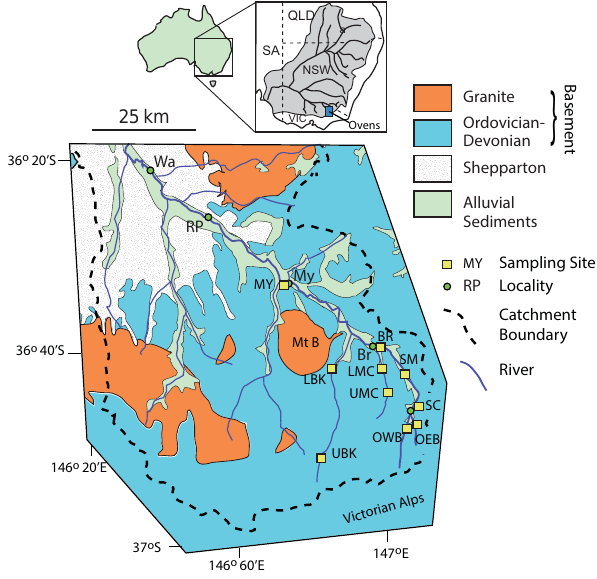
Figure 1. Summary geological and location map of the Ovens catchment, data from Energy and Earth Resources (2015). Sam- pling sites: BR = Bright, LBK = Lower Buckland, LMC = Lower Morses Creek, MY = Myrtleford, OEB = Ovens East Branch, OWB = Ovens West Branch, SC = Simmons Creek, SM = Smoko, UBK = Upper Buckland, UMC = Upper Morses Creek. Localities: Br = Bright, Ha = Harrietville, My = Myrtleford, Mt B = Mount Buffalo; RP = Rocky Point, Wa = Wangaratta. Inset map shows location of Ovens Valley relative to the Murray-Darling Basin (shaded); NSW = New South Wales, QLD = Queensland, SA = South Australia, VIC =